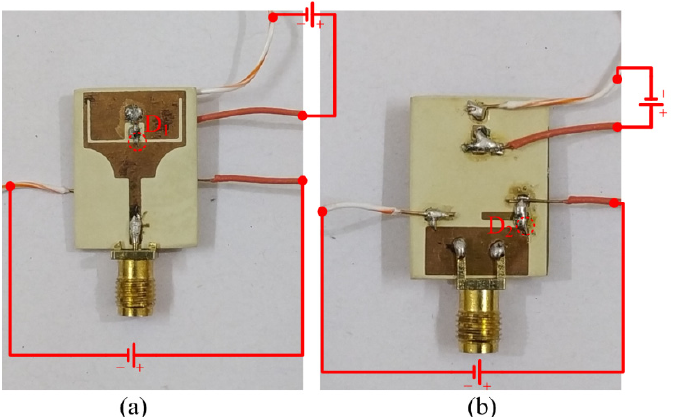
Figure 9. Fabricated prototype of the proposed antenna, along with biasing configuration; ( a ) top- view; ( b ) bottom view.